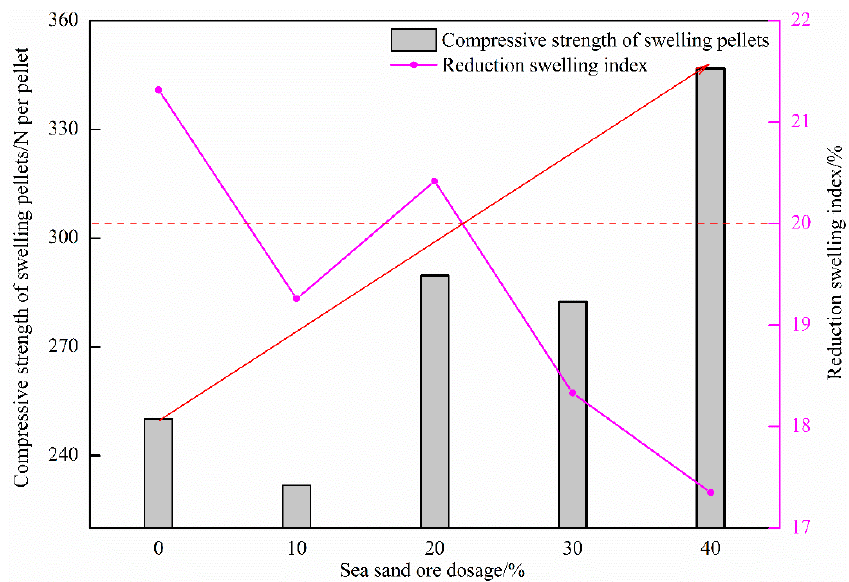
Figure 10. Effect of sea sand ore dosage on reduction swelling index of oxidized pellets and compressive strength of swelling pellets.